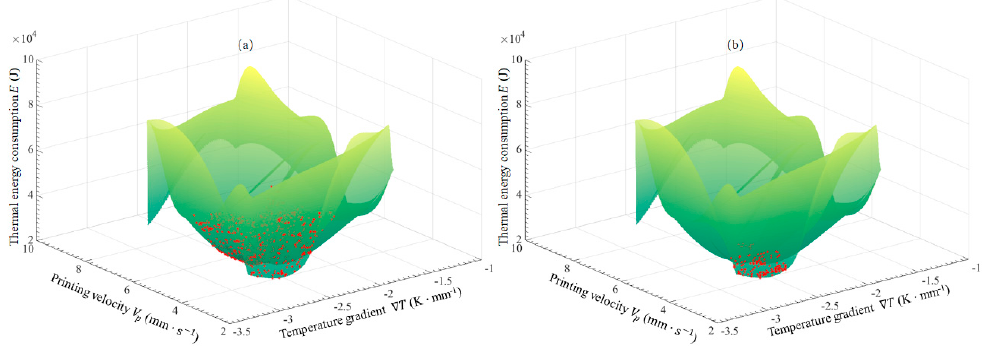
Figure 8. Pareto Optimal Solutions (POS) using Convolutional Generative Adversarial Network (CGAN) . ( a ) is before optimization and ( b ) is after optimization.